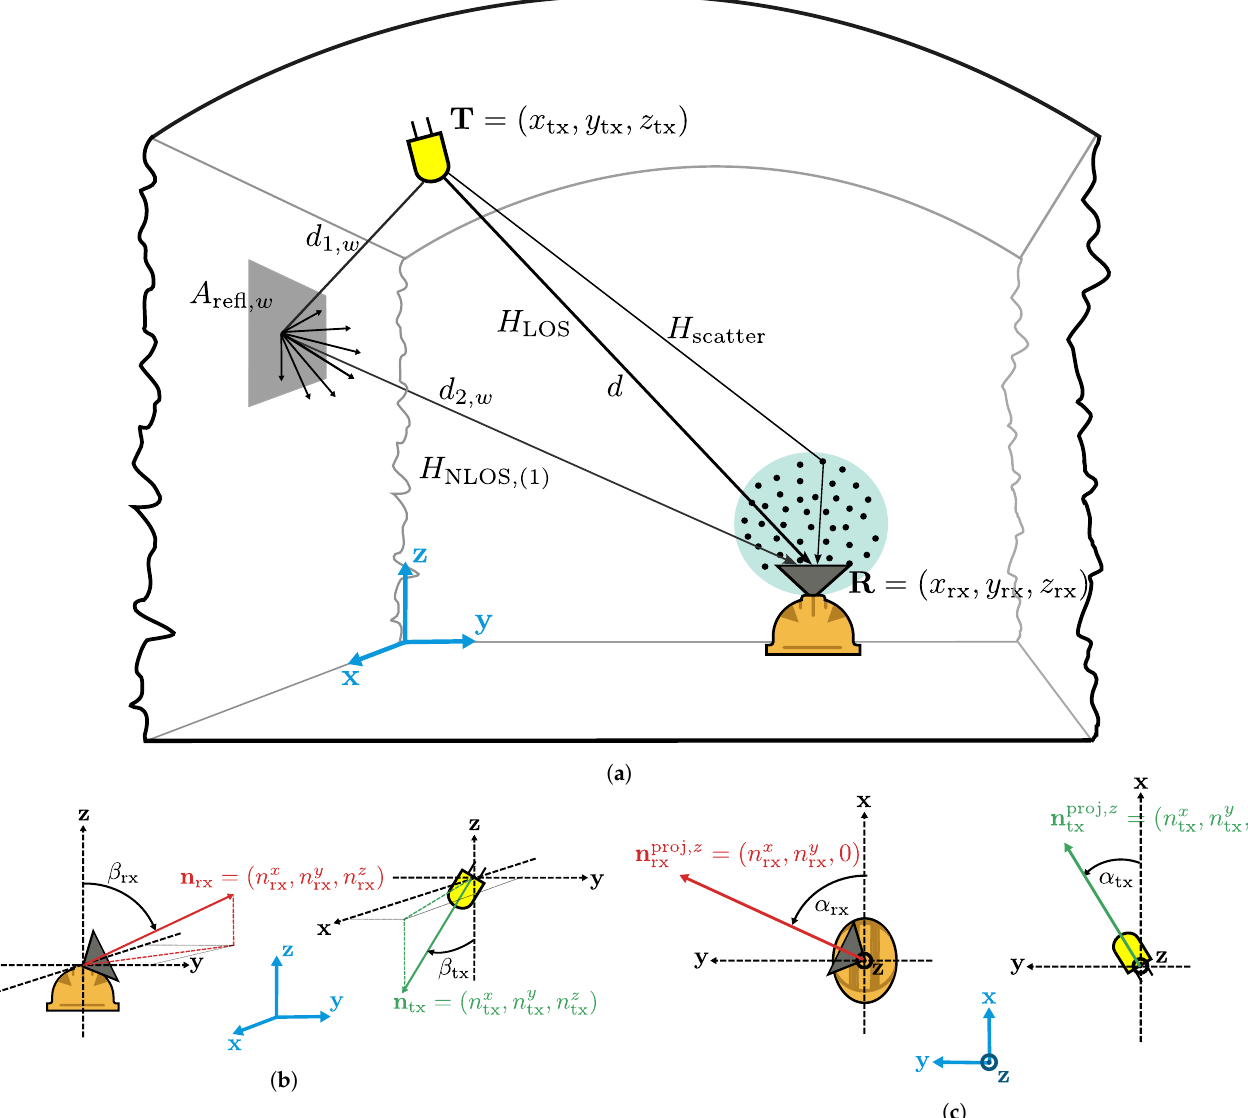
Figure 1. Reference UM-VLC channel model. ( a ) Channel components from Equation (27). ( b ) Tilt angles β rx and β tx . ( c ) Rotation angles α rx and α tx